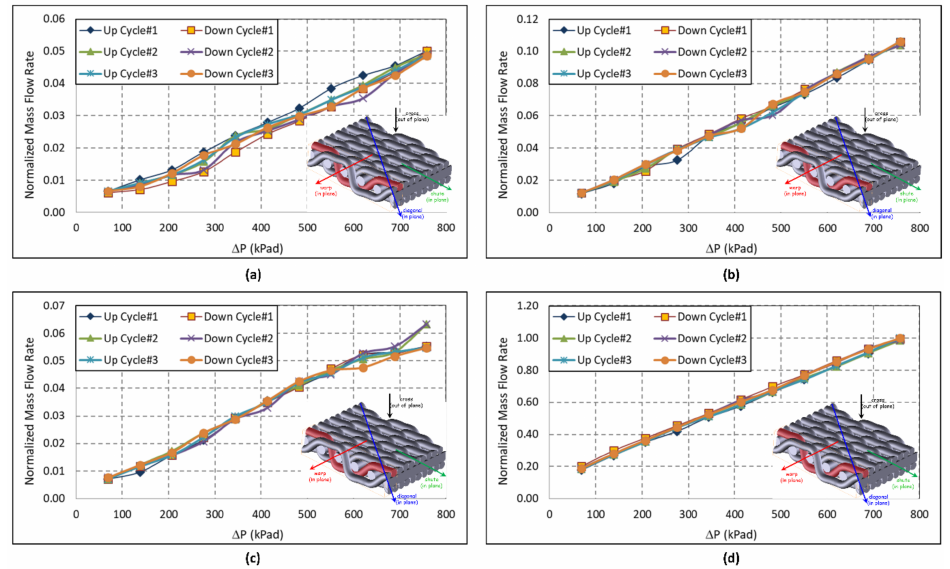
Figure 11. Metallic-cloth fiber leakage test results: ( a ) warp direction, ( b ) shute direction, ( c ) diagonal direction, and ( d ) cross